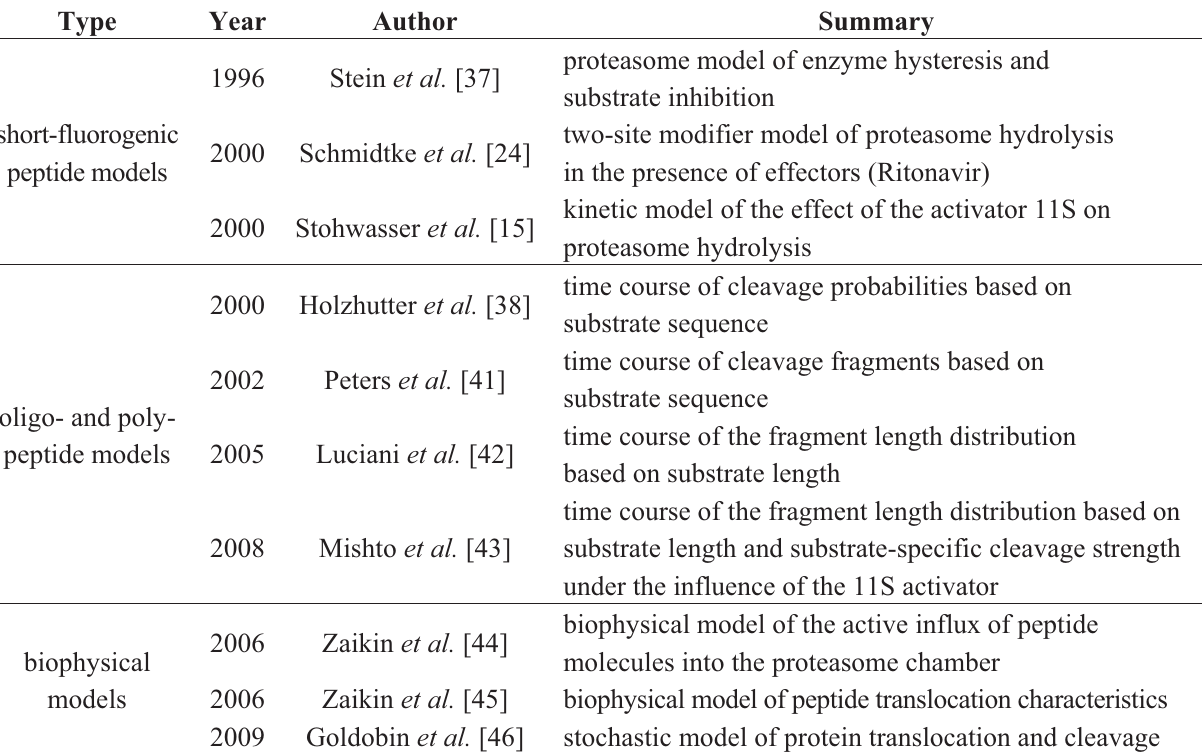
Table 1. Overview of published mathematical models of proteasome peptide